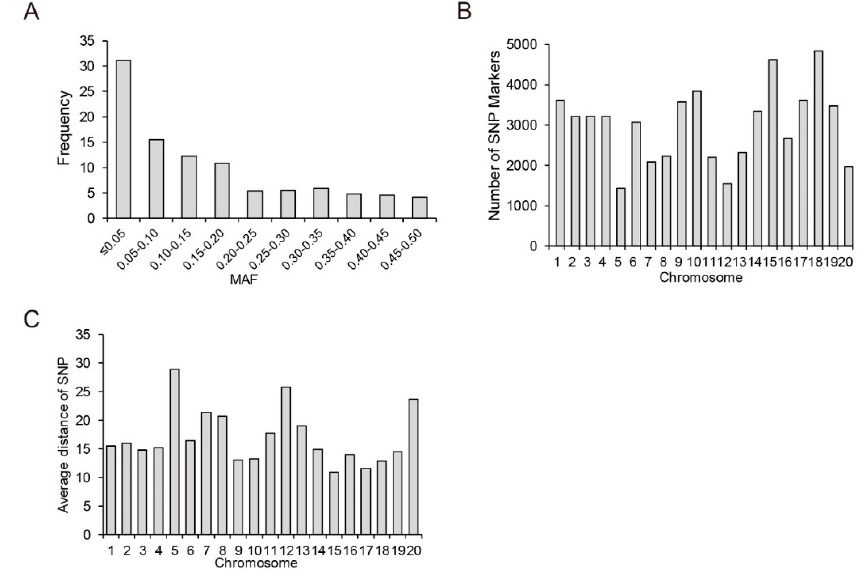
Figure 2. Distribution analysis of 60,109 SNPs across 347 lines. ( A ) Distribution of minor allele frequency (MAF). ( B ) Distribution of SNPs on 20 chromosomes. ( C ) Average distance of SNPs on 20 chromosomes.